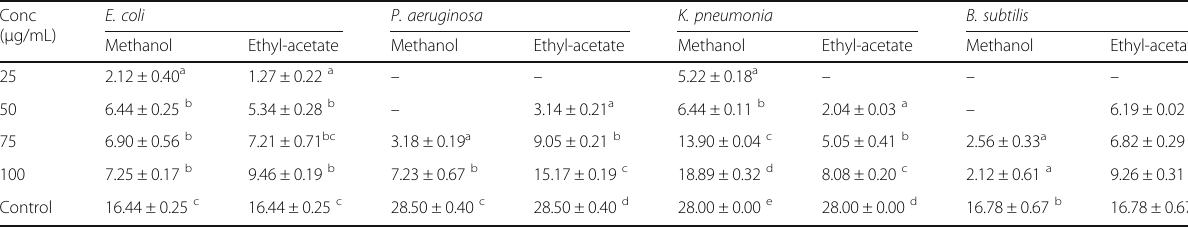
Table 5 Zones of inhibition of methanol and ethyl-acetate extracts of Azanza Conc ( μ